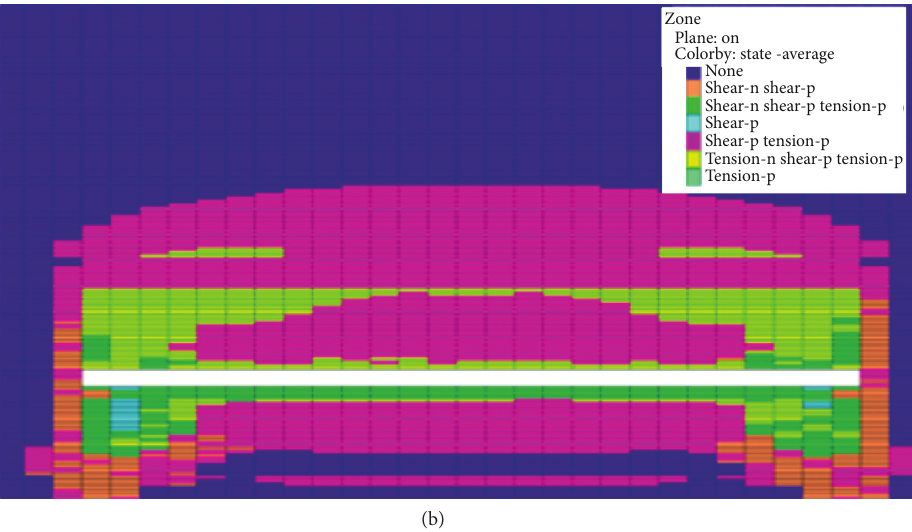
Figure 3: Working face at different mining distances tends to floor failure area distribution. (a) Mining 80m. (b) Mining 120m.